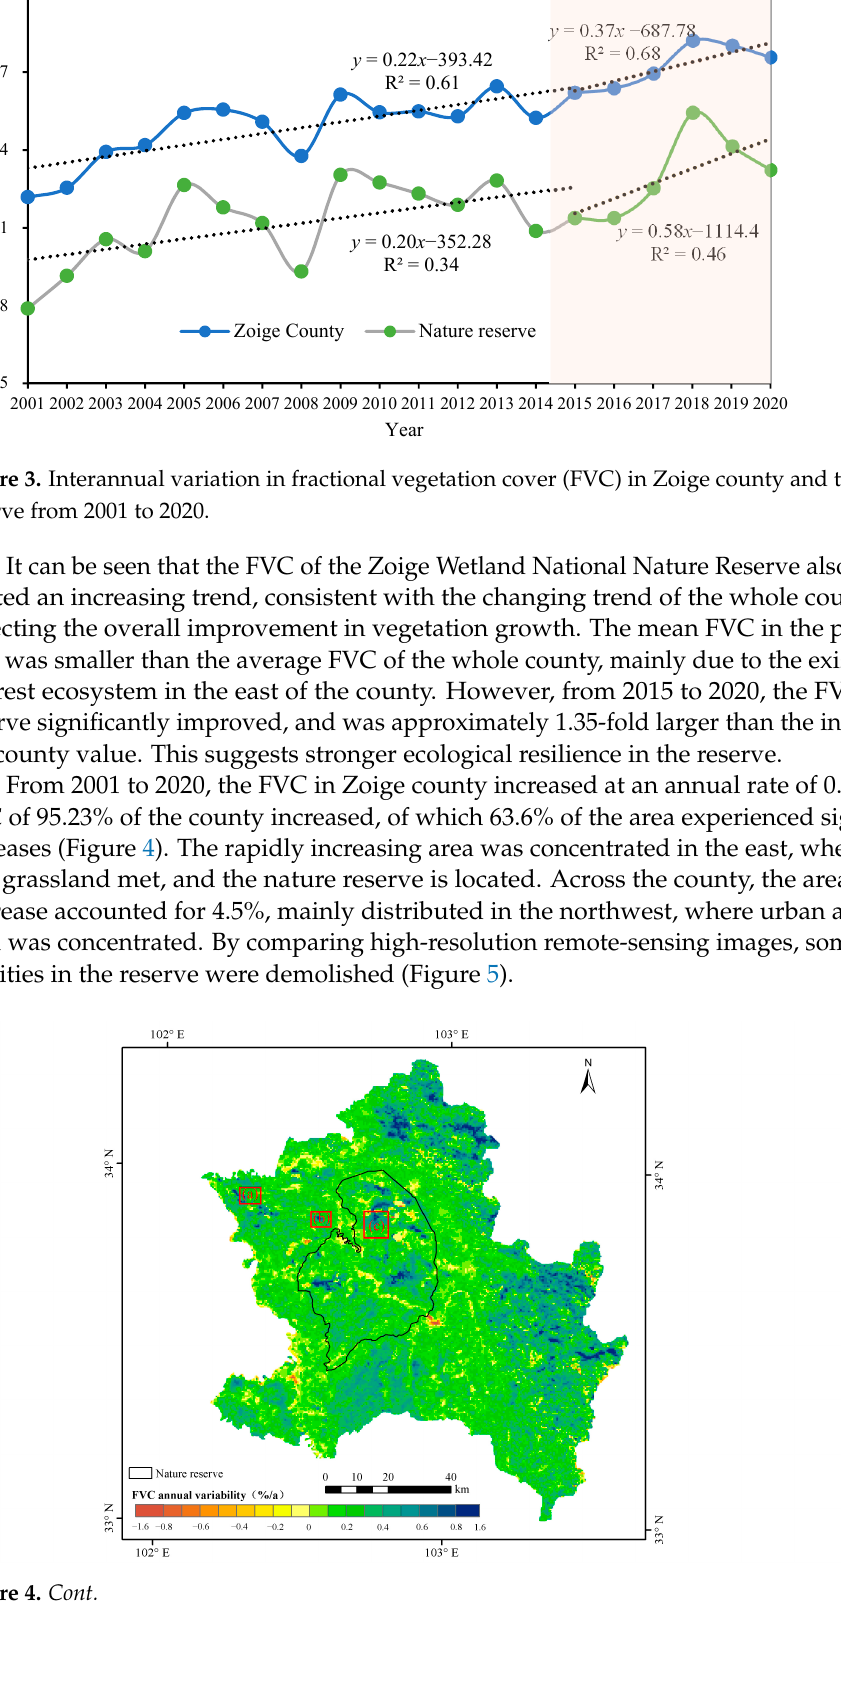
Figure 4. Changes in trend of fractional vegetation cover (FVC) in Zoige county from 2001 to 2020: ( (a), (b) and (c) are the remote-sensing image comparison maps and vegetation coverage change time- series map of three typical ecological engineering implementation points. High-resolution remote- sensing images are from Google Earth and Chinese GF-1 satellites.